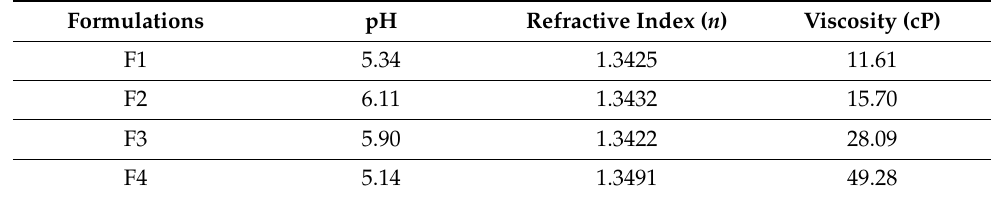
Table 2. pH, refractive index, and viscosity analysis results of the prepared nanoemulsions.